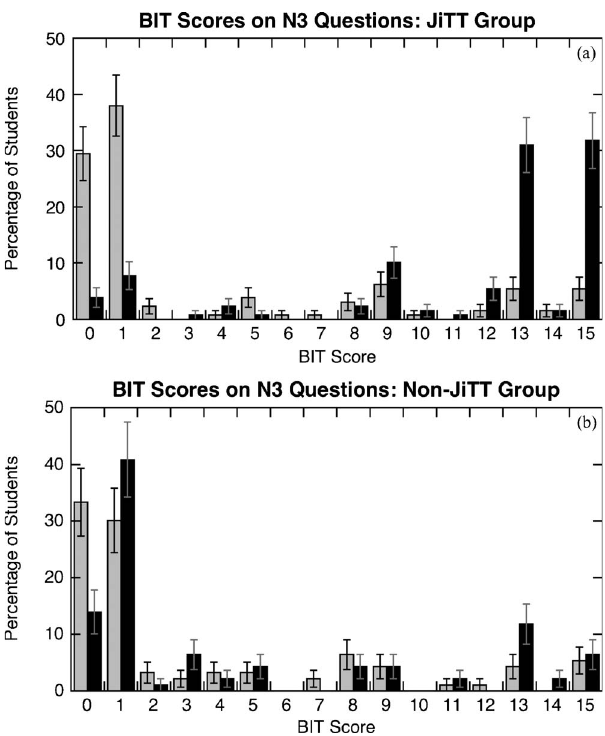
FIG. 2. BIT Coding for the FCI-N3 pretests (cid:1) gray (cid:2) and post-tests (cid:1) black (cid:2) . (cid:1) a (cid:2) JiTT and (cid:1) b (cid:2) Non-JiTT.